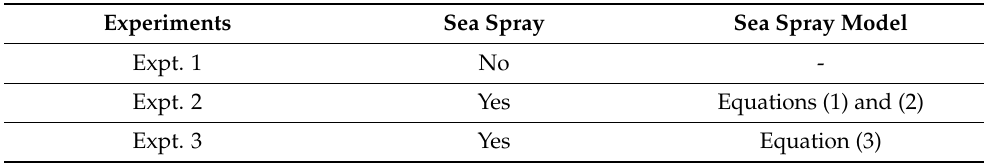
Table 1. Experimental design in this